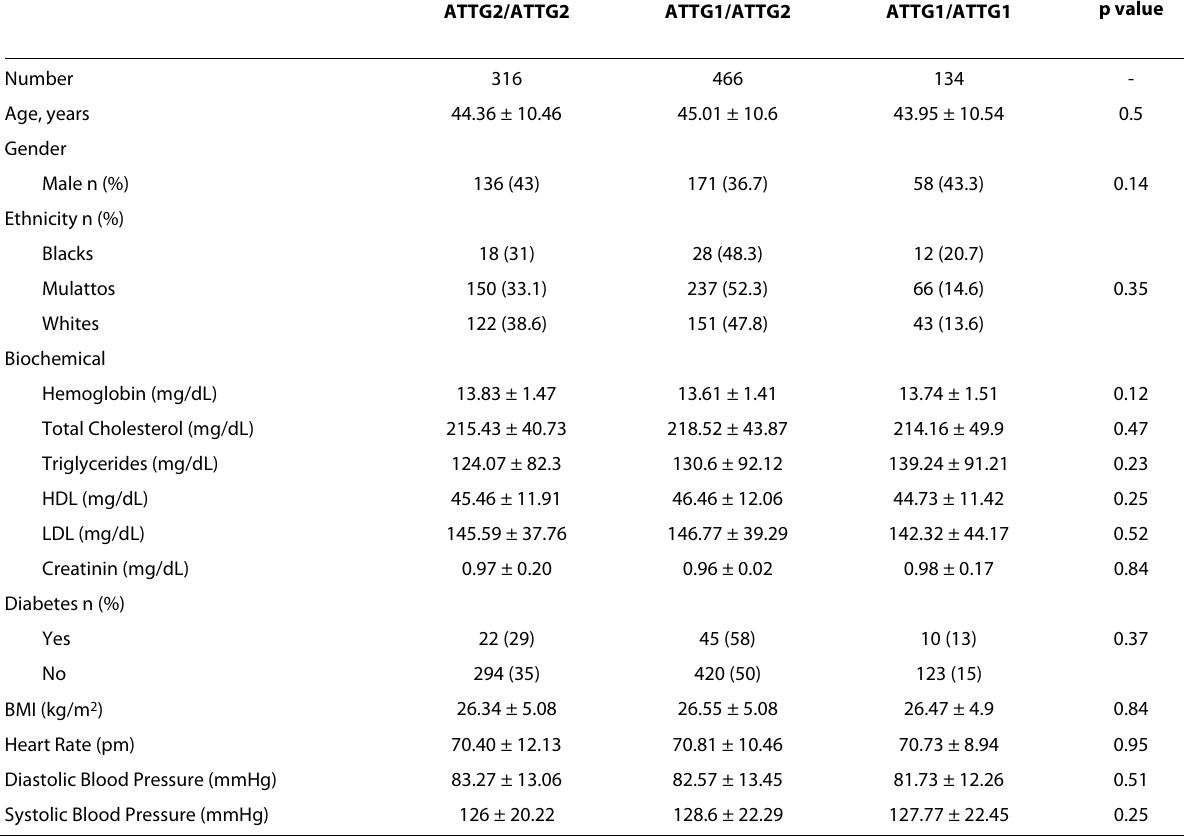
Table 3: Demographic and clinical characteristics of the Control population according to -94 insertion/deletion